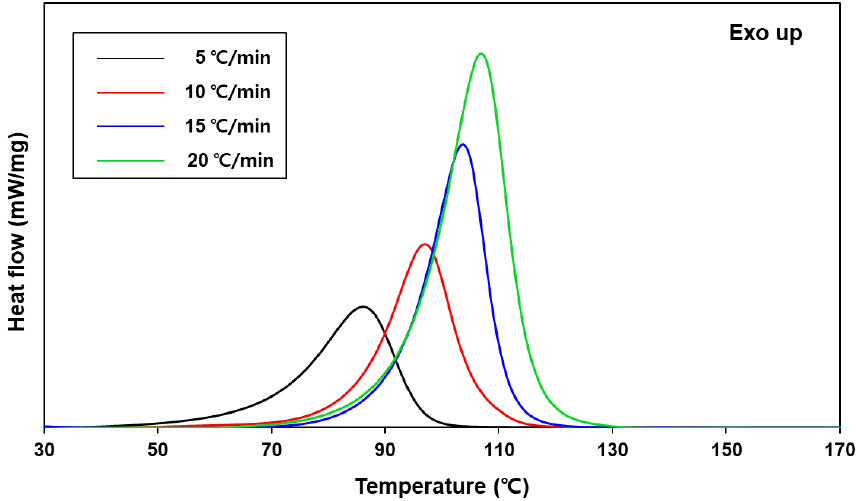
Figure 2. DSC thermograms of epoxy/thiol/MI system obtained at various heating rates. After data obtained from the DSC analysis were converted to ln( β / T p 2 ) and 1/ T p , the apparent activation energy ( E a ) and pre-exponential factor (A) were calculated based on the Kissinger equation (Equation (1)) [21] (Figure 3a). The E a and A values of the epoxy/thiol/MI curing were calculated to be 67.76 KJ/mol and 2.26 × 10 8 min −1 from the slope and y-intercept of the plotting line of 1/ T p vs. ln( β / T p 2 ). The apparent activation en- ergy was also calculated based on the Ozawa equation (Equation (2)) [22] (Figure 3b). The linear relation between 1/ T p and ln( β ) was obtained, and the E a value was calculated to be 70.25 KJ/mol from the slope of the line.